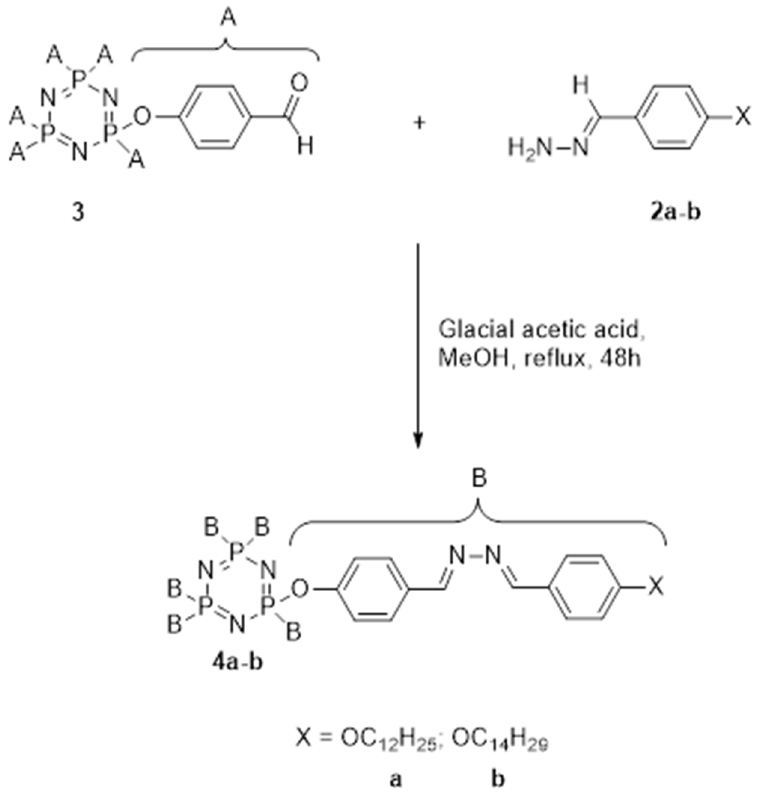
Scheme 4. Synthesis of hexasubstituted cyclotriphosphazene compounds, 4a-b